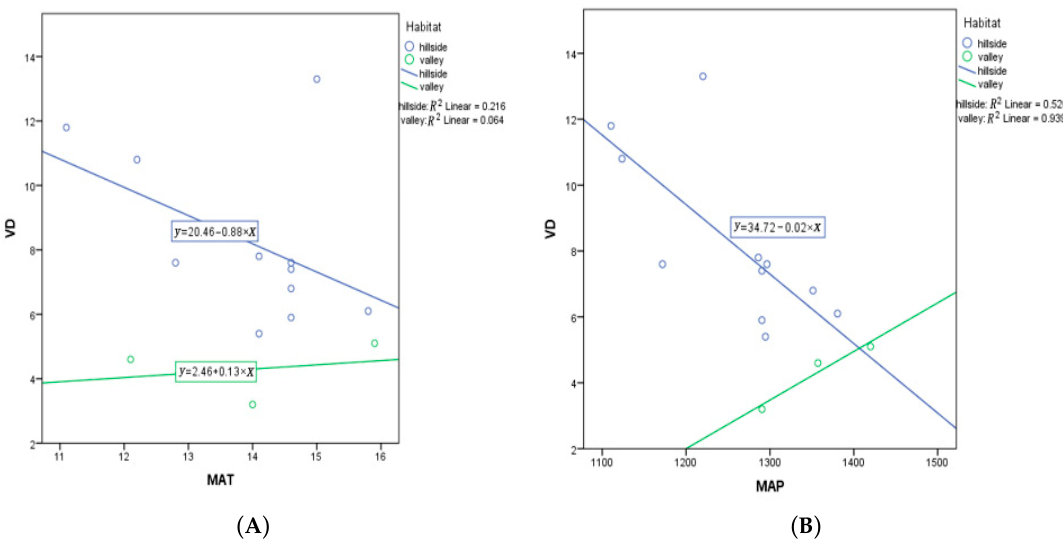
Figure 10. ( A ) ANCOVA between vein density (VD) and MAT in hillside vs. valley habitats; ( B ) ANCOVA between vein density (VD) and MAP in hillside vs. valley habitats. Each dot represents a sampling site in China.